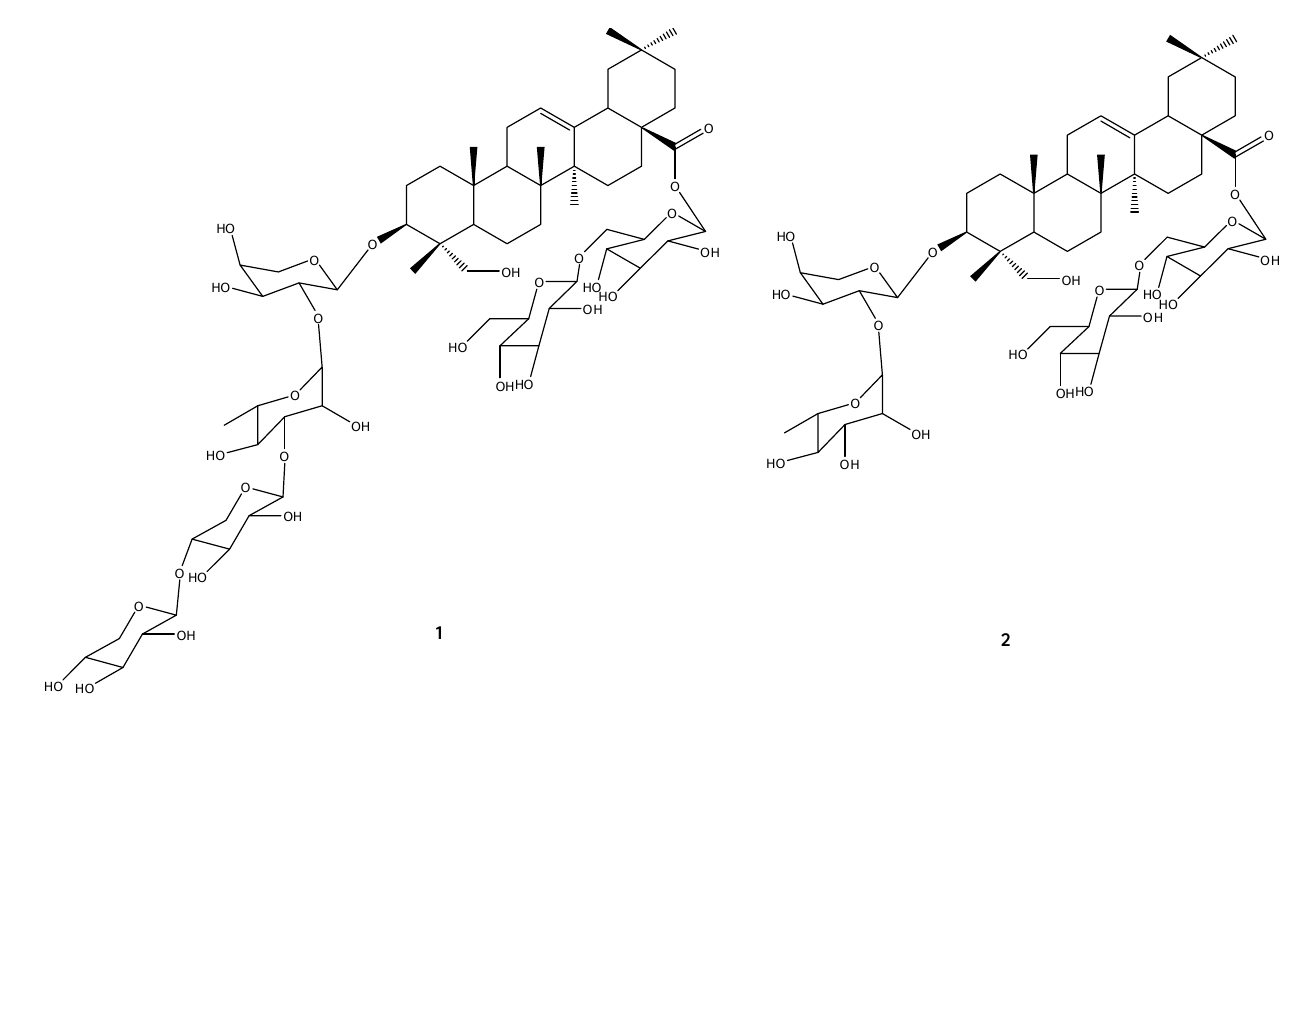
Figure 1. Structures of compounds 1 and 2